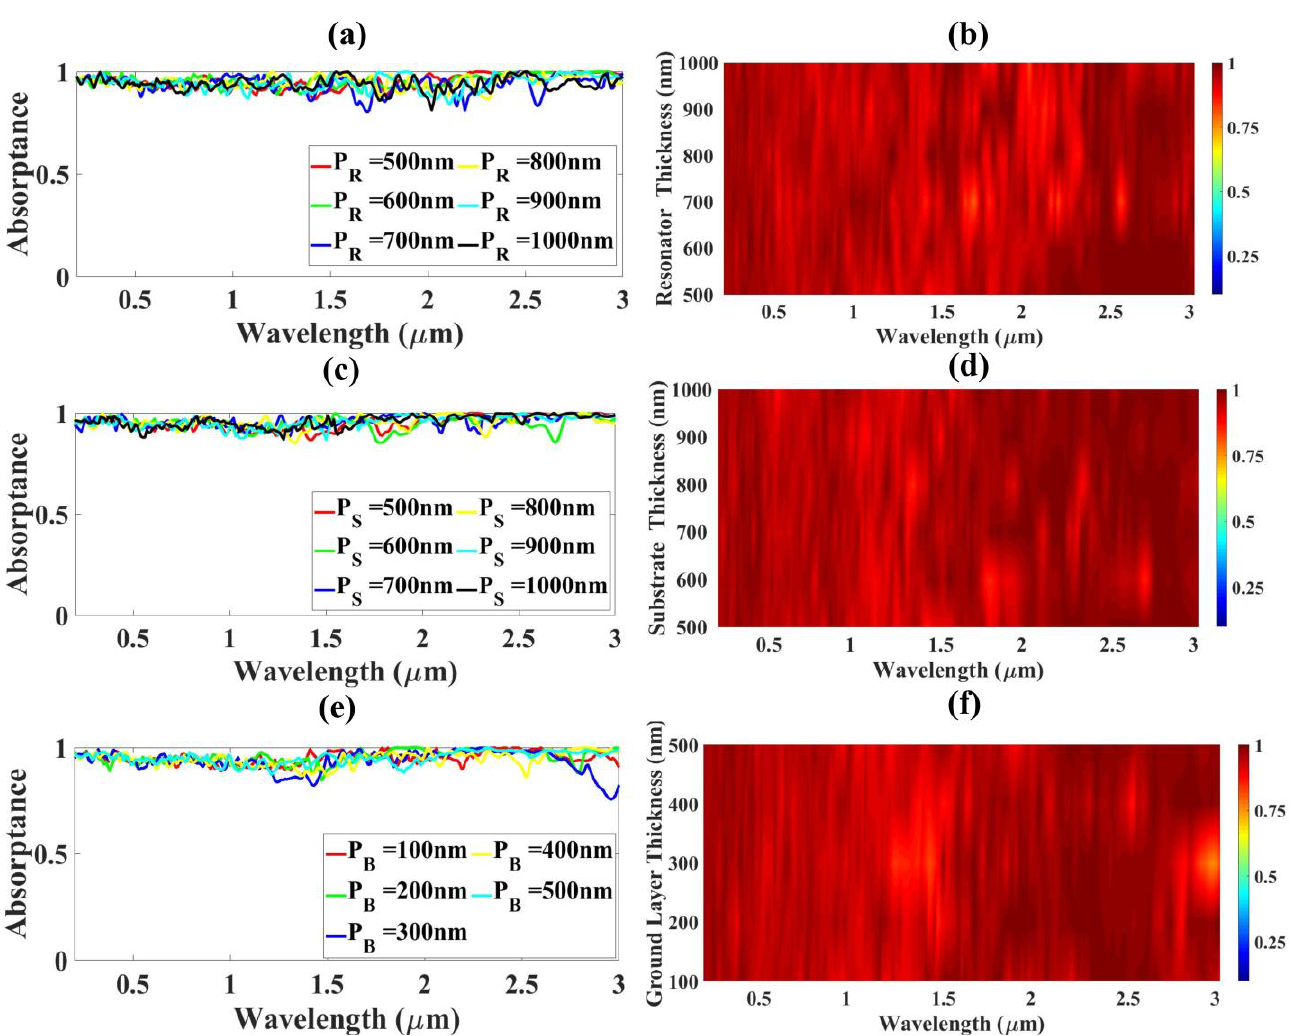
Figure 6. The proposed concentric GST ring resonator solar absorber’s absorption rate ( a ) absorption rate of concentric GST ring resonator solar absorber by increasing the GST ring structural height, P R , ( b ) absorption rate of concentric GST ring resonator solar absorber by increasing the GST ring structural height, P R demonstrated by fermi plot, ( c ) absorption rate of concentric GST ring resonator solar absorber by increasing the SiO 2 substrate layer thickness, P S , ( d ) absorption rate of concentric GST ring resonator solar absorber by increasing the SiO 2 substrate layer thickness, P S demonstrated by fermi plot, ( e ) absorption rate of concentric GST ring resonator solar absorber by increasing the Cr ground layer thickness, P B , ( f ) absorption rate of concentric GST ring resonator solar absorber by increasing the Cr ground layer thickness, P B , demonstrated by the color plot.